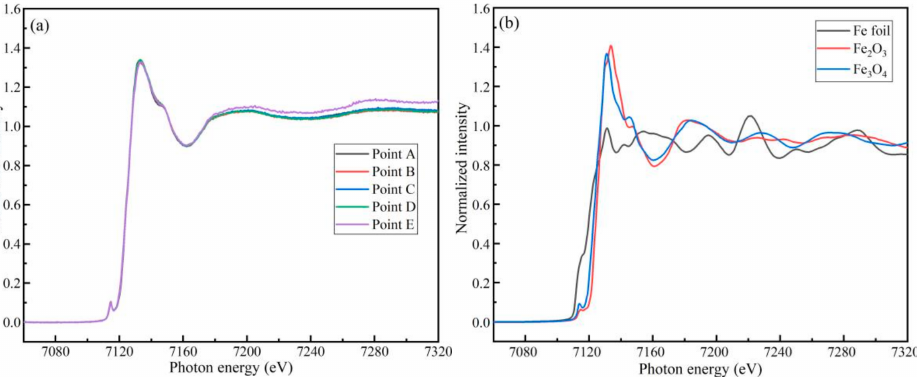
Figure 2. Fe K-edge XANES spectra: ( a ) the HF sample (points A, B, C, D, E correspond to the crystallization zone); ( b ) standard spectra of iron foil (Fe), hematite (Fe 2 O 3 ), and magnetite (Fe 3 O 4